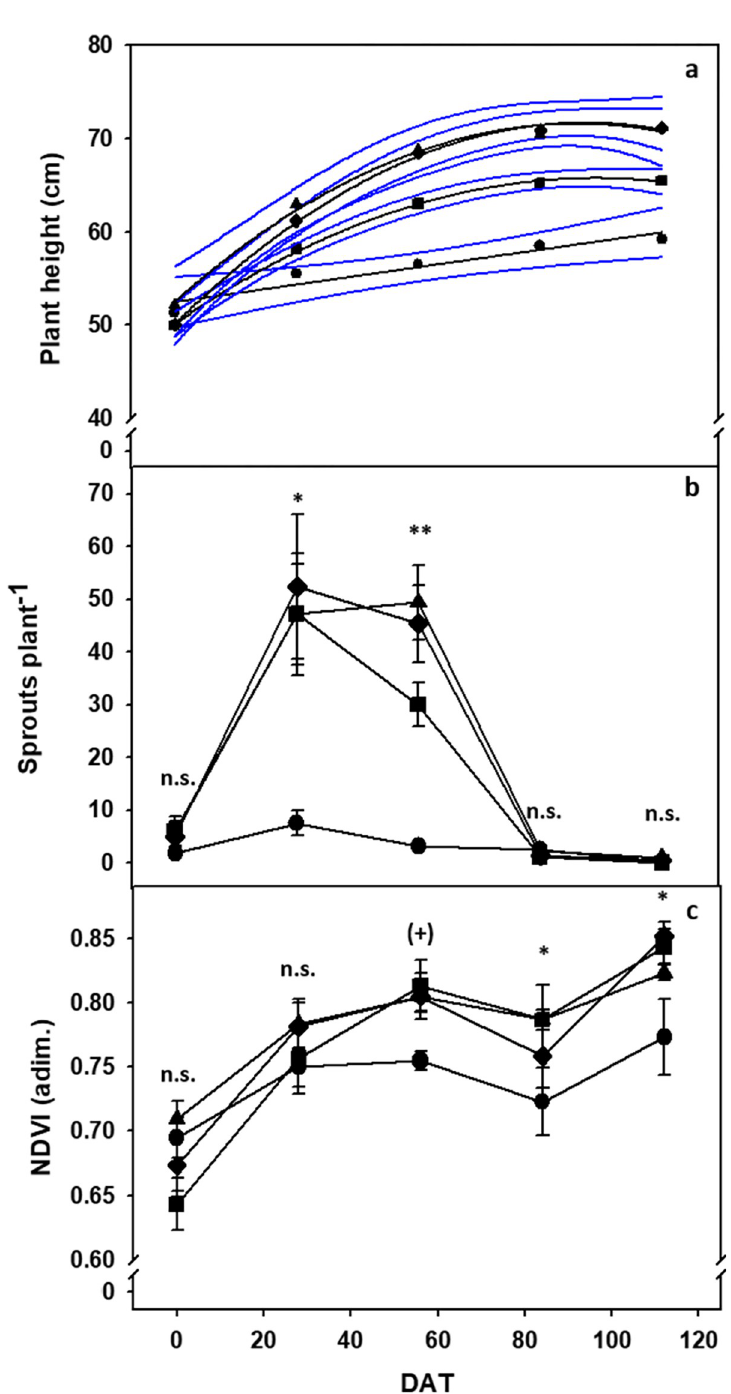
Fig 3. Morphology analysis. Plant height (a), number of sprouts per plant (b), and normalized difference vegetation index (NDVI) (c) at various days after treatment (DAT) in Taxus baccata exposed to different light intensity. Circles, squares, diamonds and triangles indicate the control and the R/B/Fr LED lamps at 50, 100 and 150 μ M m -2 s -1 , respectively. In plant height, the 95% confidence bands for the time trends of the four treatments are shown; in the other two traits, vertical bars indicate ± SE (n = 6); n.s., (+) , � and �� indicate non-significant and significant at P � 0.10, P � 0.05 and P � 0.01, respectively.